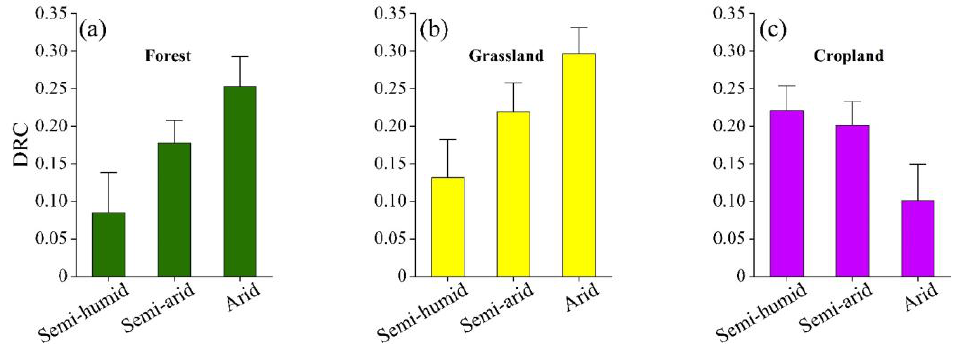
Figure 4. Mean DRC (Drought Resistance Coefficient) of forest ( a ), grassland ( b ), and cropland ( c ) across climate zones. Error bar is 1 SD.